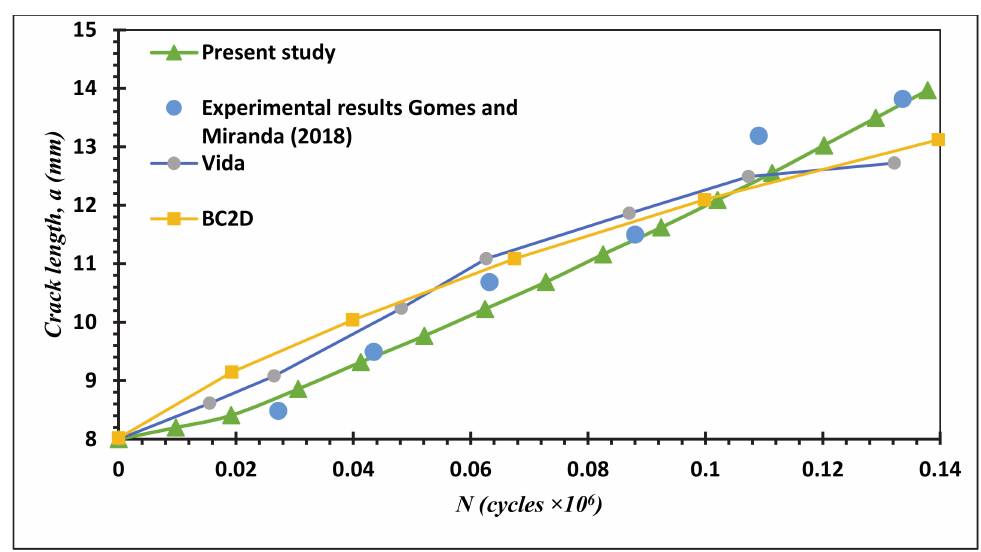
Figure 18. Fatigue life for the MCTS,